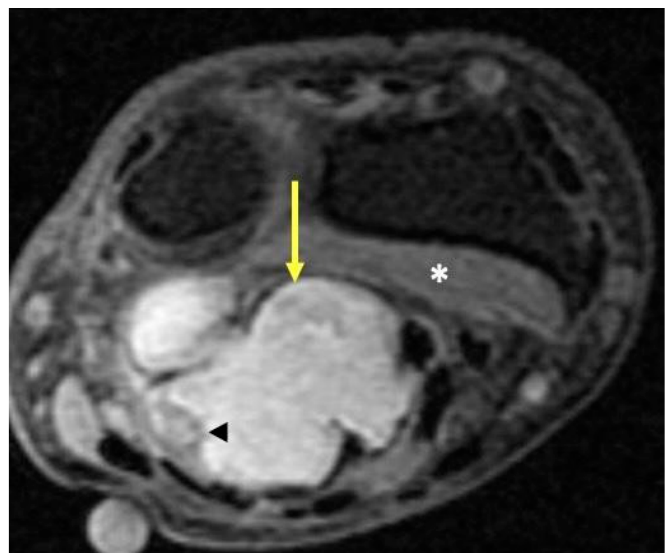
Figure 13. Synovial sarcoma. Fat ‐ suppressed T2 ‐ weighted axial MR image of the wrist just proximal to the distal radioulnar joint shows a high ‐ signal ‐ intensity lobulated volar mass (arrow) deep to the superficial flexor tendons and overlying the pronator quadratus (*). Internal areas of necrosis and hemorrhage may lead to areas of signal heterogeneity due to evolving blood products within the tumor (arrowhead).